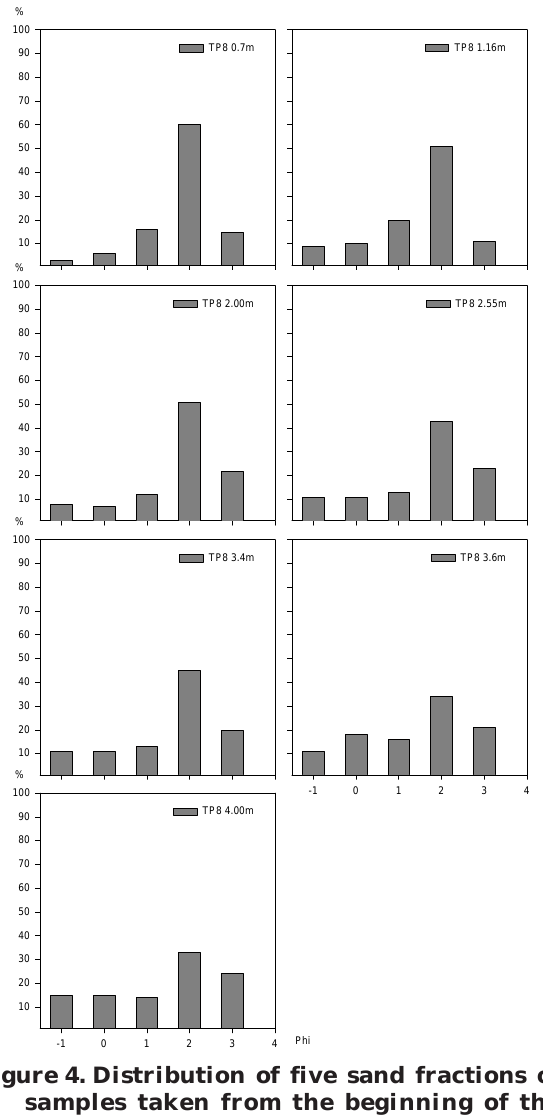
Figure 4. Distribution of five sand fractions of samples taken from the beginning of the transition between the sandy material and the red clayey deposit that overlies the Irati